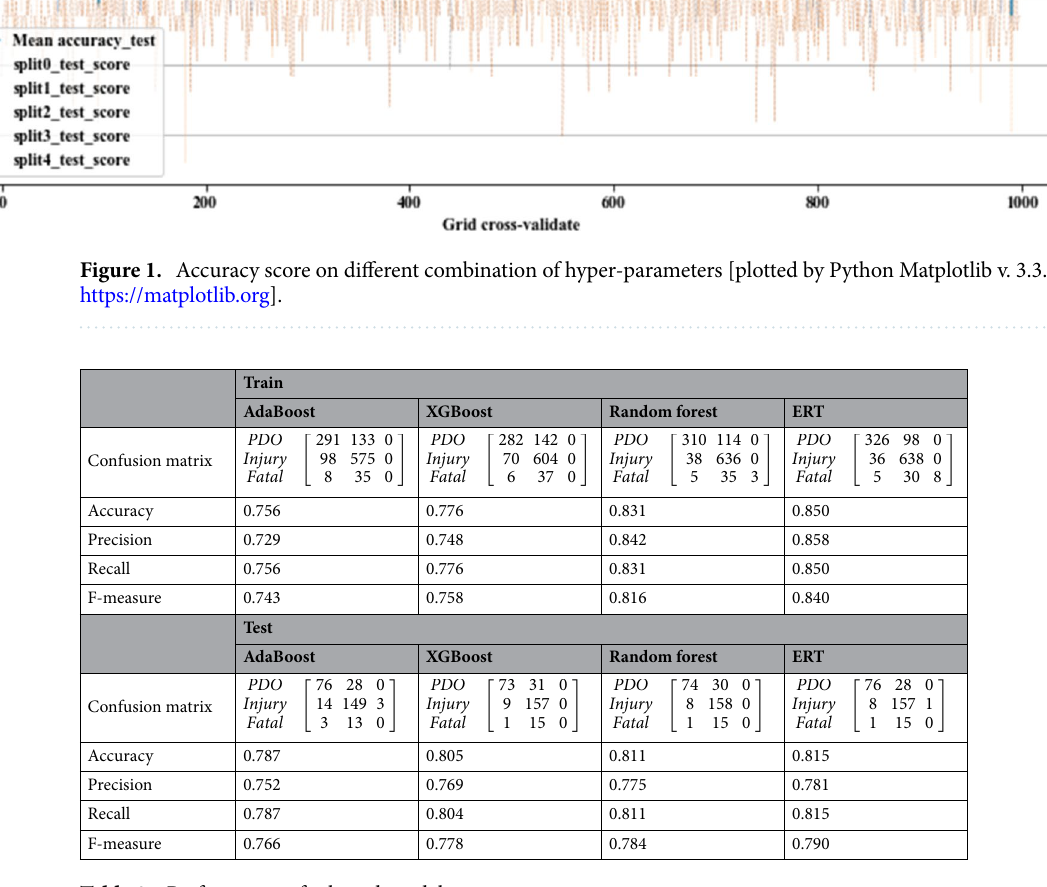
Table 3. Performance of selected